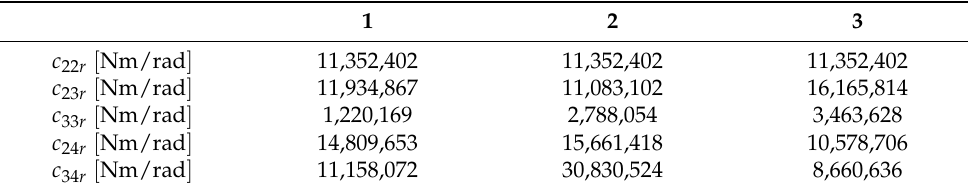
Table 5. Parameters of elastic components.